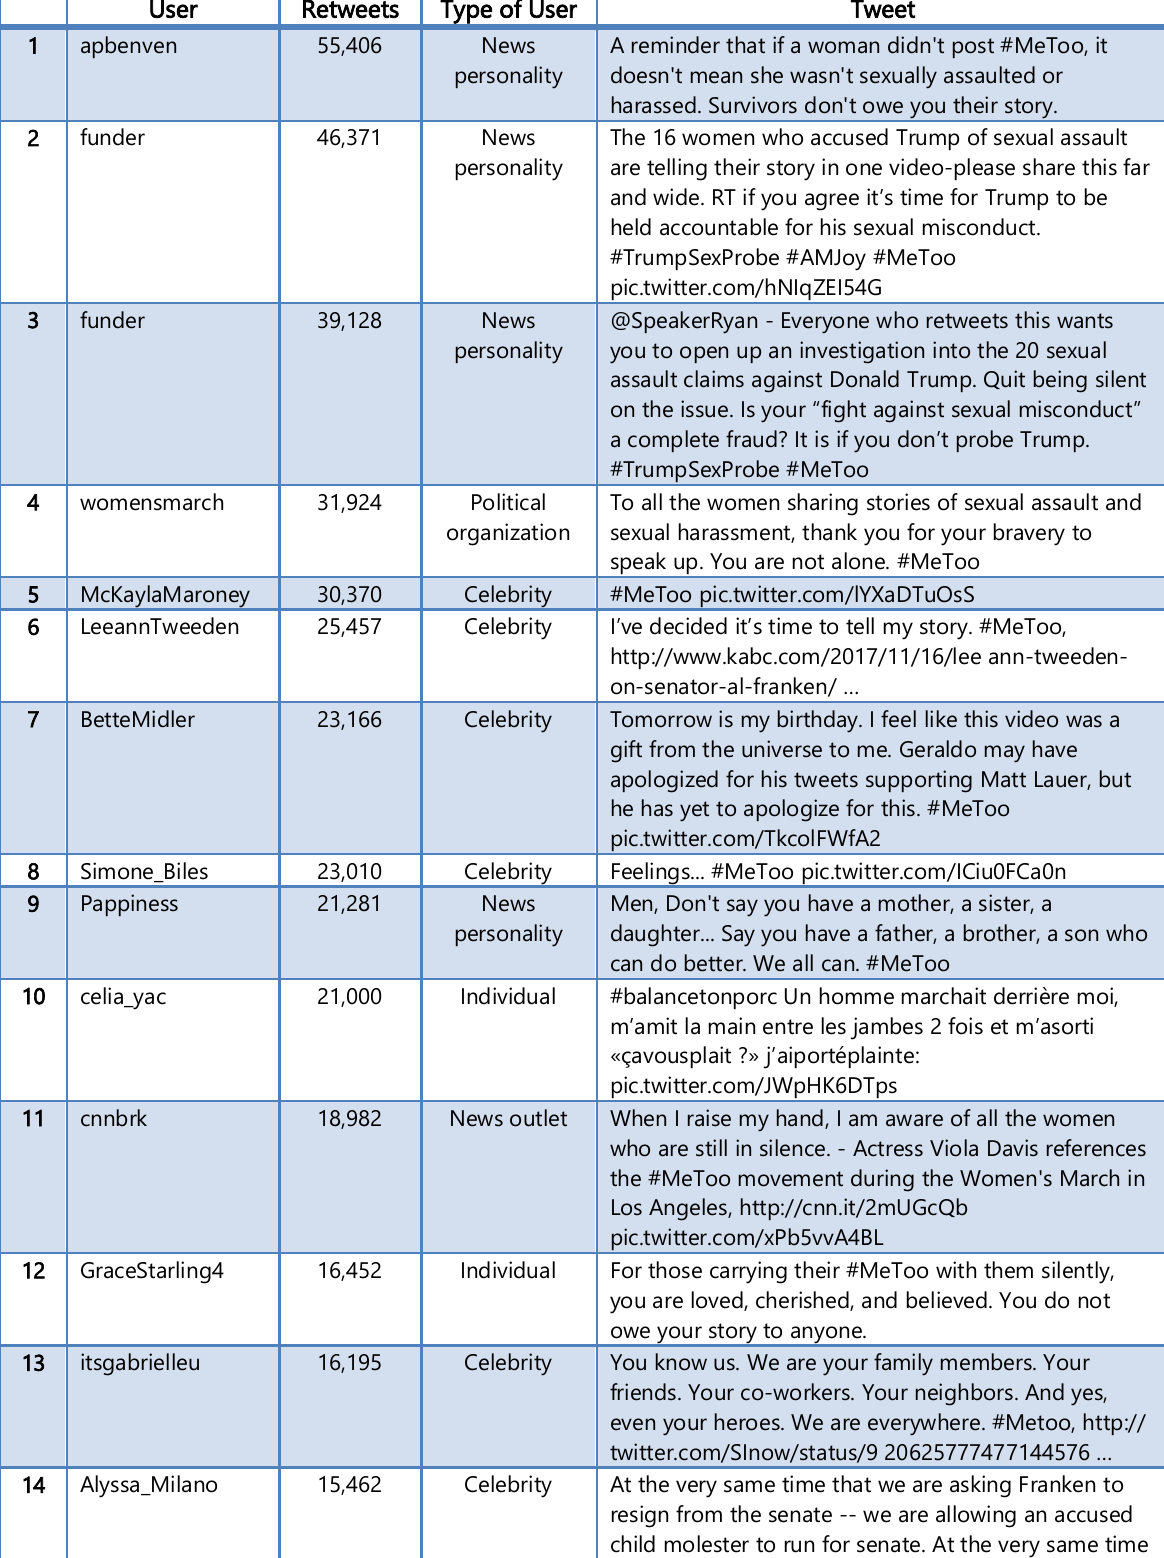
Table 2: Most Retweeted Tweets in the Dataset (Source: Authors‘